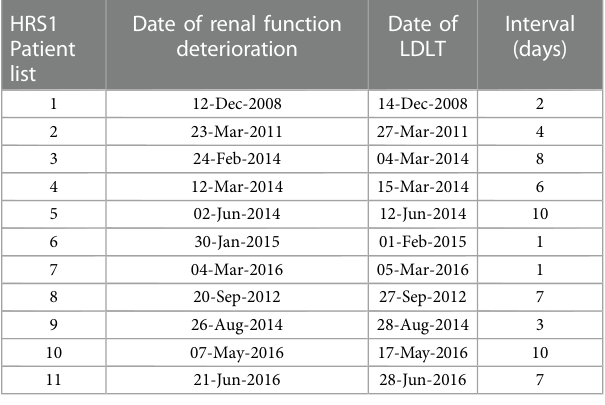
TABLE 3 Interval time from onset of HRS1 to transplantation.